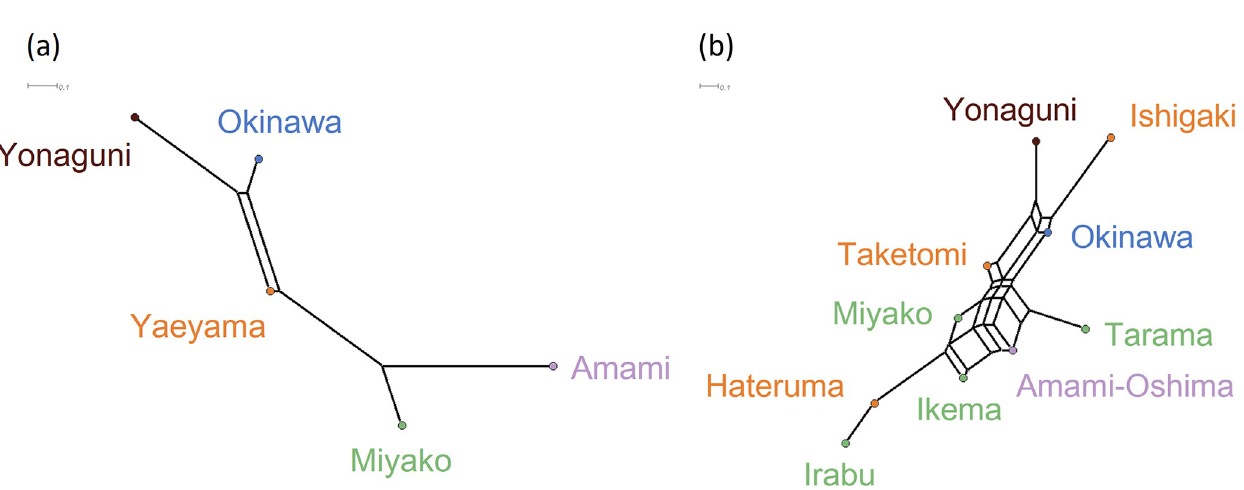
Fig 3. Neighbor-Net graphs. (a) Neighbor-Net graph based on the musical distances between 1,342 songs of the five regions in the Ryukyu Archipelago ( δ = 0.346). (b) Neighbor-Net graph based on the musical distances between 870 songs of the ten islands for which linguistic data were available ( δ = 0.456). Colors indicate the